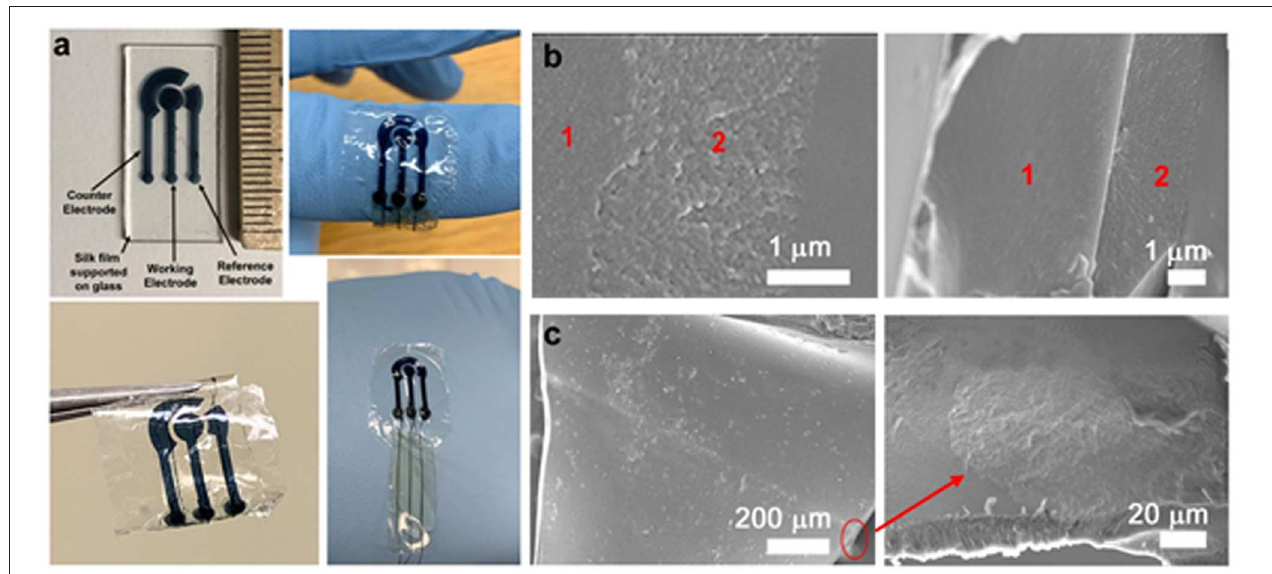
FIGURE 2 | (a) Sensor design showing the position of the working, reference, and counter electrodes. The biosensors with the core-sheath PEDOT:PSS wires/fibroin sheaths are conformable, flexible and can be subjected to mechanical deformation. (b) SEM images of the cross section of the organic electrodes, showing the underlying fibroin substrate (1) and sericin-PEDOT:PSS conductive microelectrodes (2). (c) SEM images of the sheathed wire showing the cross-section and the PEDOT:PSS wire (red circle), a closeup of which can be seen in the bottom right